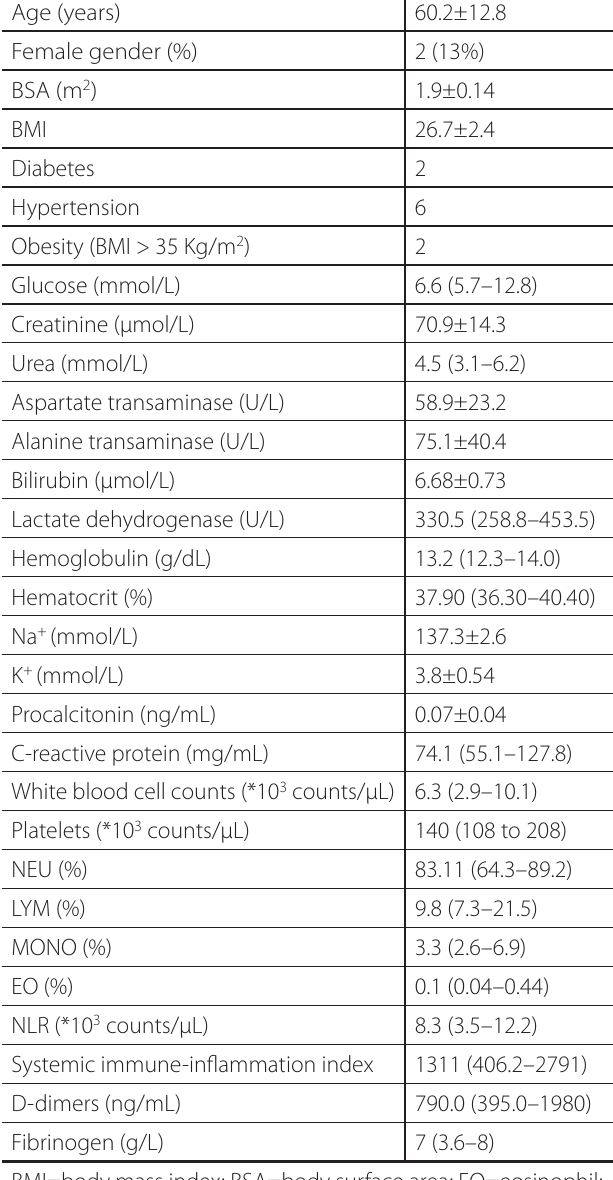
Table 1 . Basic patient